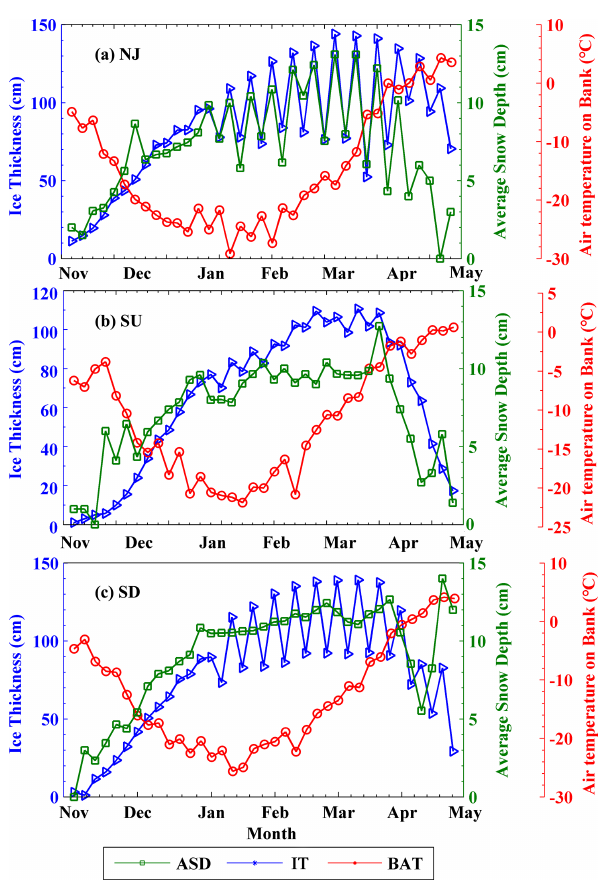
Figure 6. Average seasonal changes in ice thickness (IT), aver- age snow depth (ASD), and air temperature on bank (BAT) from November to April for the period 2010–2015.